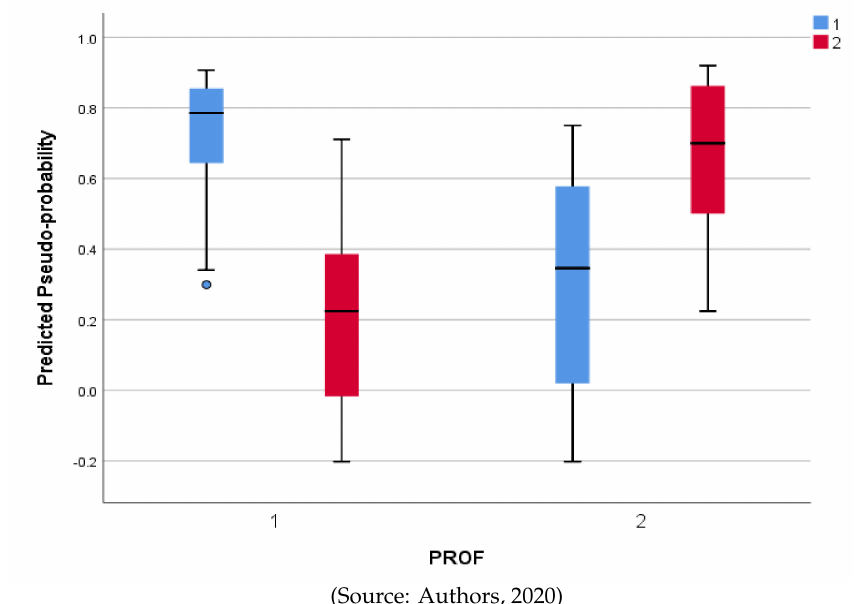
Figure 2. Predictive pseudo-probability for the level 1 training.